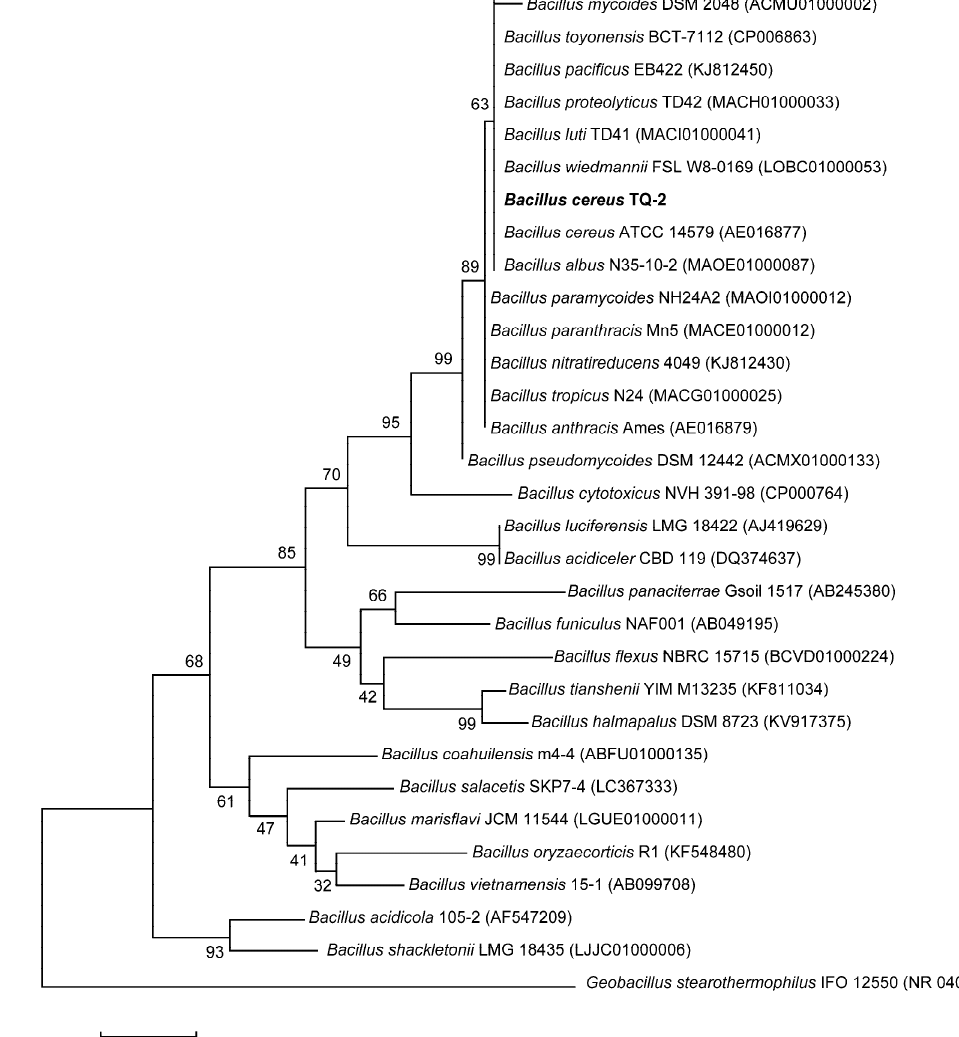
Figure 3. The phylogenetic tree based on 16S rDNA sequences, exhibiting the revolutionary status of B. cereus TQ-2 among related taxa. The tree was constructed by the neighbor-joining method, and the numbers in parentheses represent the sequences accession number in the GenBank database .